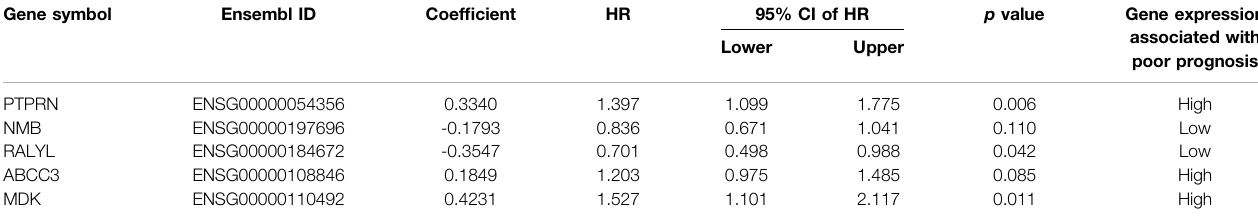
TABLE 3 | Five mRNAs selected as prognosis-associated factors in GBM.